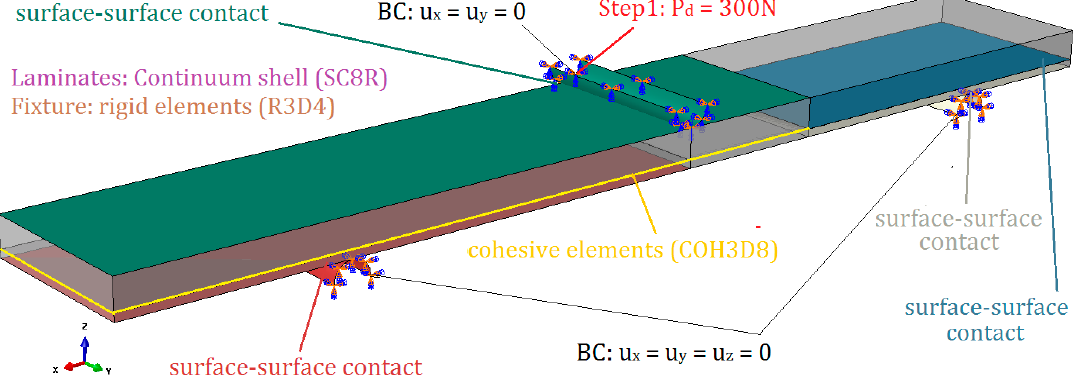
Figure 7. Boundary conditions and types of finite element applied in the numerical model.